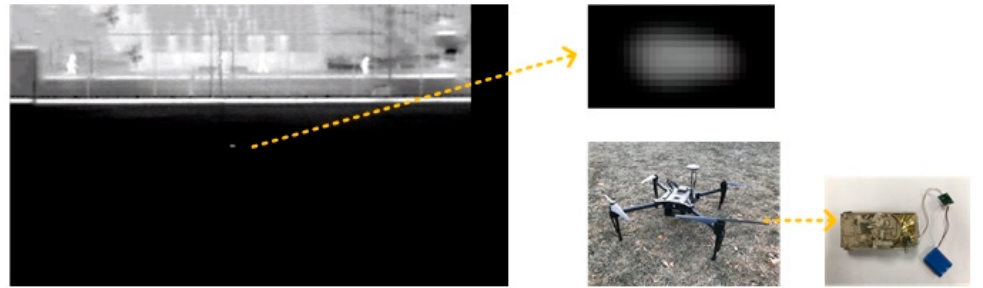
Figure 10. Experiment of the dim infrared target detection under the proportional scaling.